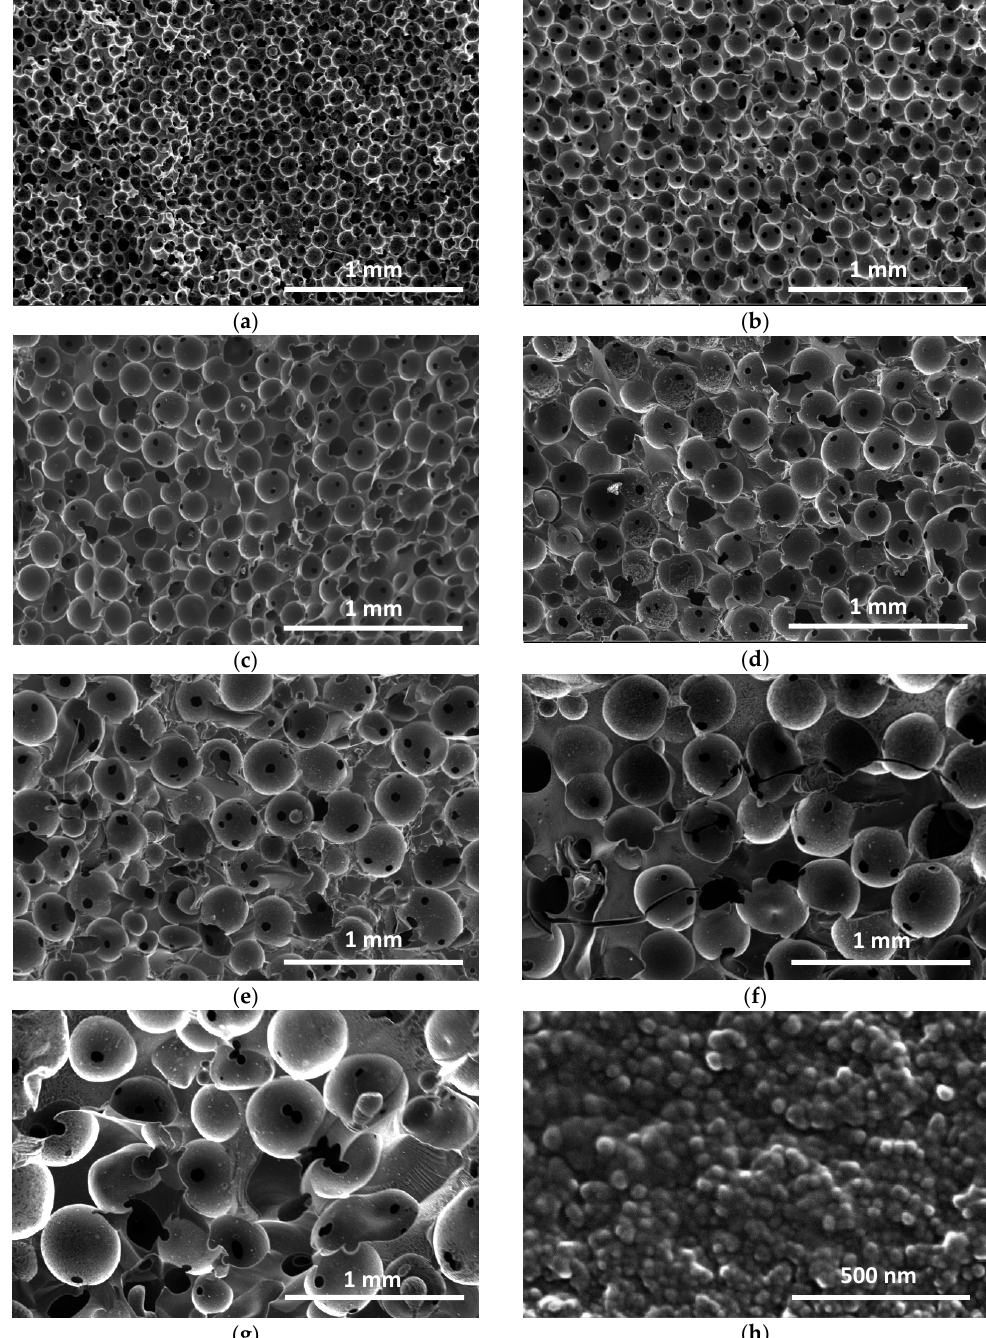
Figure 8. SEM pictures of cellular carbon monoliths prepared with paraffin beads of different sizes: ( a ) CRF150; ( b ) CRF250; ( c ) CRF350; ( d ) CRF450; ( e ) CRF550; ( f ) CRF700; ( g ) CRF900. ( h ) View of a cell wall of CRF350 sample at high magnification.